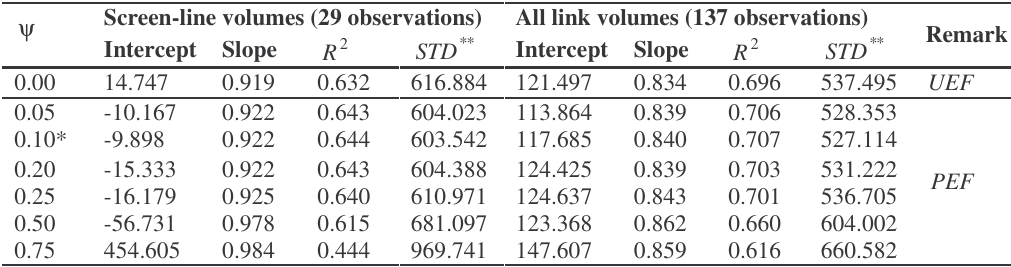
Table 2. Results of regression analysis between model predicted and observed link volumes for the City of